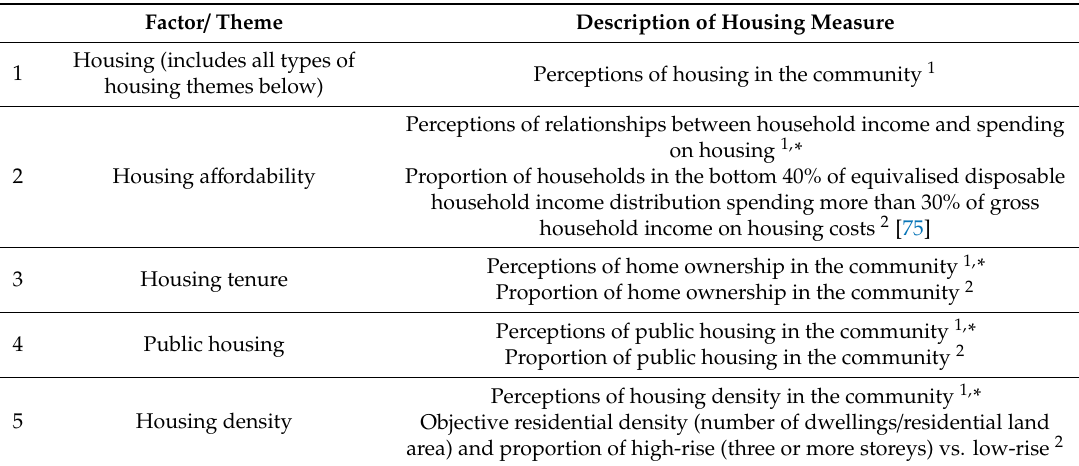
Table 1. Housing measures of interest in the Kids in Communities